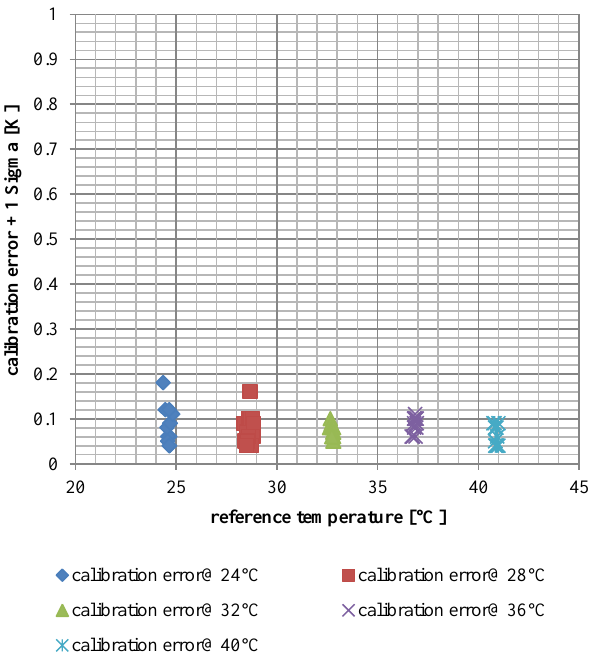
Figure 20. Temperature value of an encapsulated sensor module at various temperatures in saline solution.